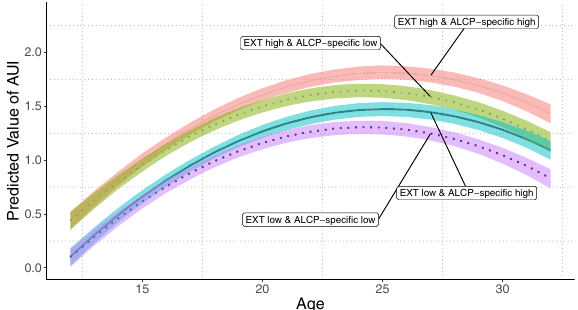
Fig. 4 Longitudinal models of polygenic associations with alcohol use and misuse. Predicted values for alcohol use index (AUI) from ages 12 to 32 using linear mixed models in Add Health ( N = 5107). Values for EXT and ALCP-speci fi c polygenic scores set to ±1.5 SD. The shaded areas represent 95% con fi dence intervals. Con fi dence intervals estimated using percentile method bootstrapping over 1000 bootstrap samples. All other covariates set to mean